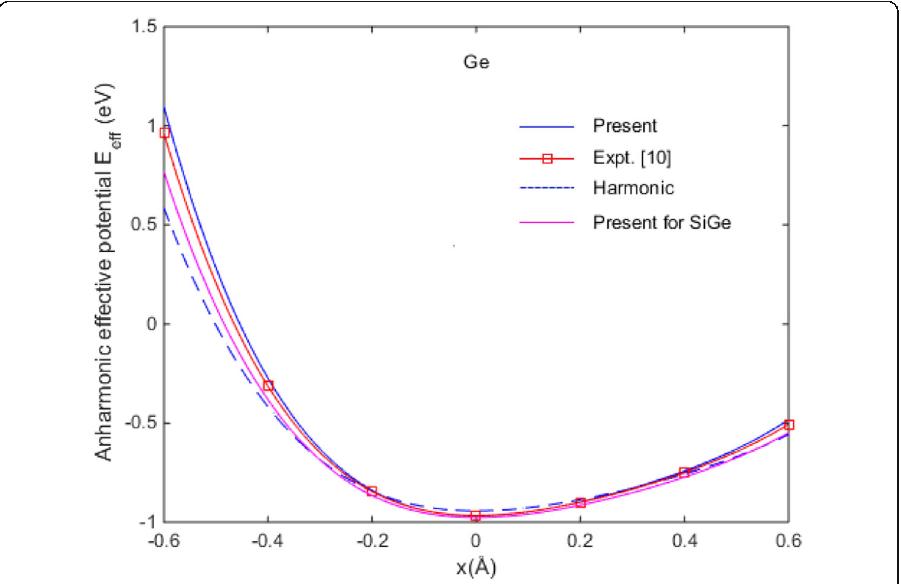
Fig. 5 Anharmonic effective potential for Ge and SiGe semiconductor and comparison with harmonic